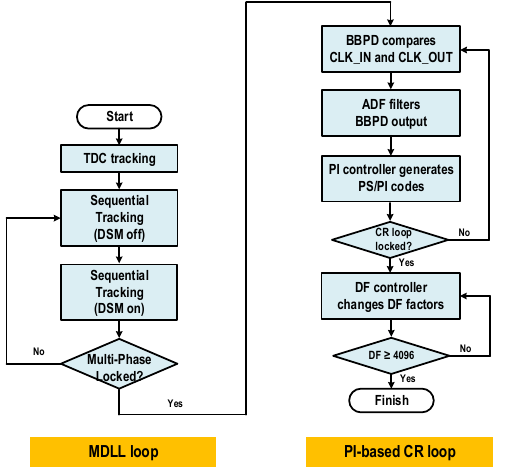
Figure 4. Flowchart illustrating the dual-loop operation of the proposed all-digital DJA.